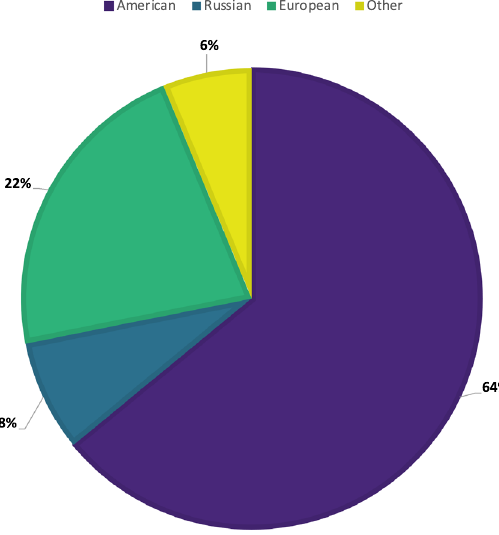
Fig. 1 National distribution of sources. Country of origin of the papers included in this